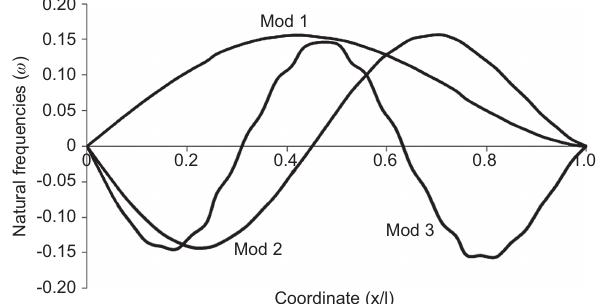
Figure 4 The first three mode shapes of symmetric (45 ° /-45 ° ) composite beam for the SS boundary condition.